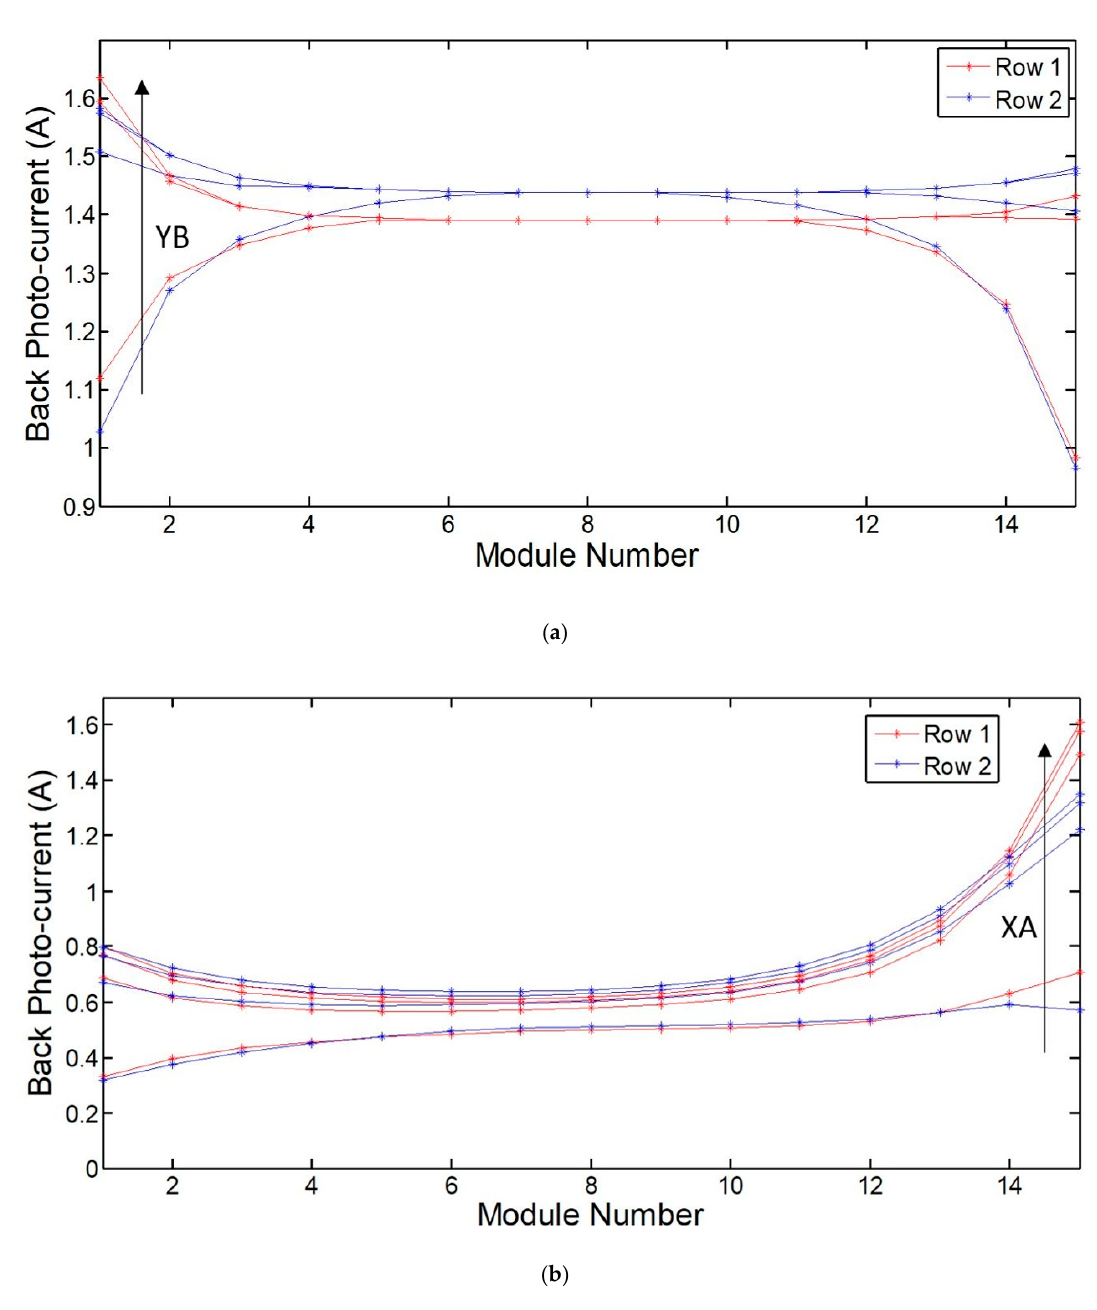
Figure 5. Rear side short circuit current levels for PV strings of 30 modules for the cases of ( a ) fixed string and ( b ) string with uniaxial horizontal solar tracker. The curves are calculated for the parameters YB and XA, respectively, in ( a , b ) (see Figure 1 for their definition), equal to 0, 5 m, 10 m, and 20 m. Curves are calculated for Catania at 10 a.m. of day n. 79. The arrows in the graphs indicate the direction of increasing YB ( a ) and XA ( b ).